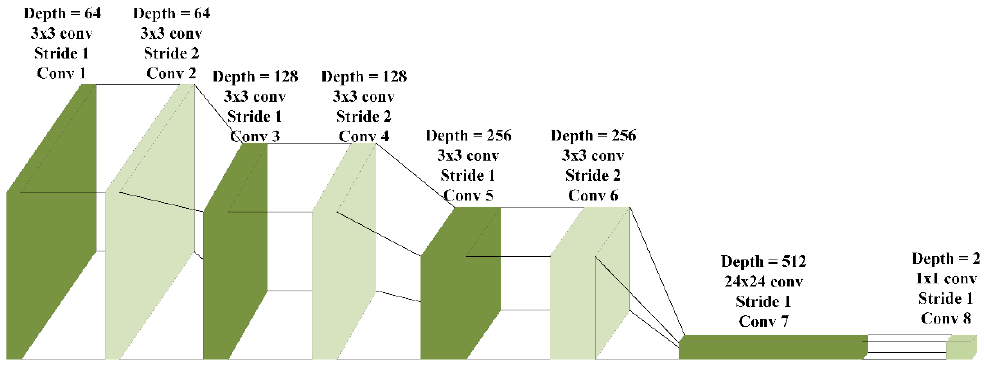
Figure 7. Architecture diagram of the VGG19 ( top ) and customized CNN model ( bottom ).